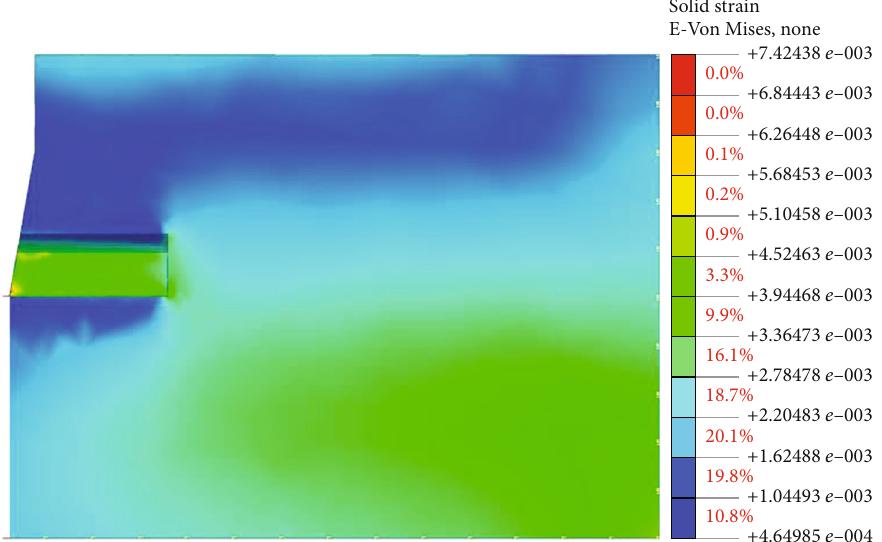
Figure 14: Strain nephogram on longitudinal section of cave dwelling under